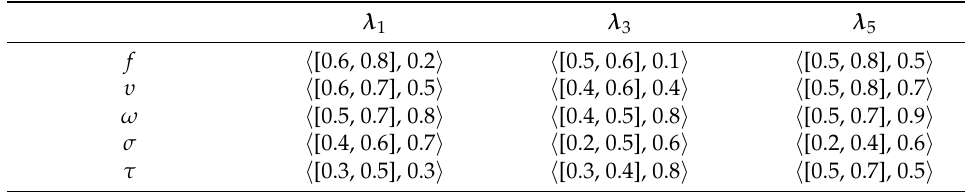
Table 2. ( Ω , (cid:60) ) is ( CS δ -SA ).